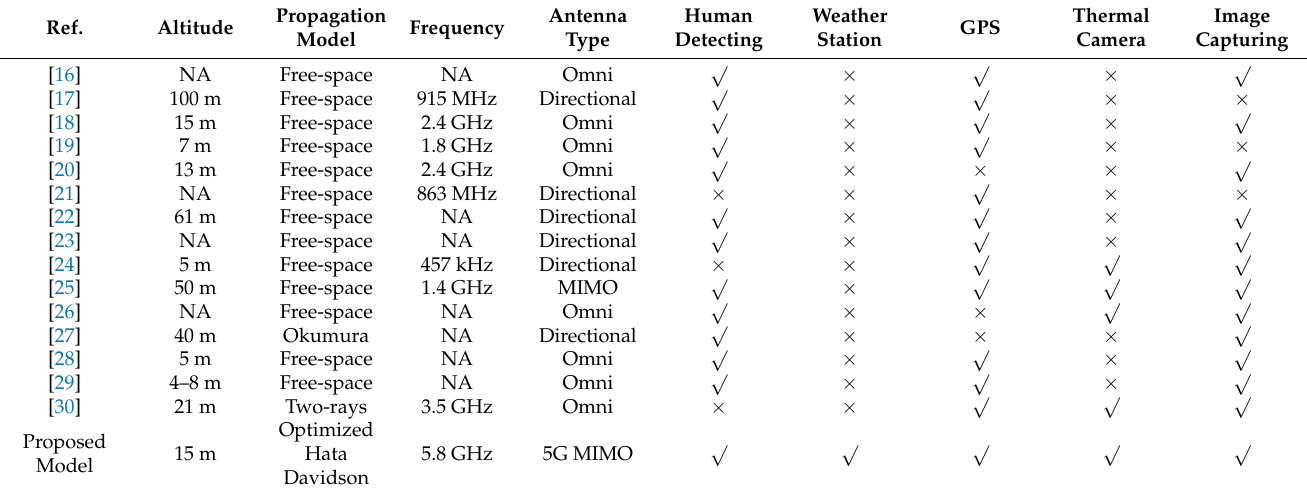
Table 5. Comparison of proposed model against existing